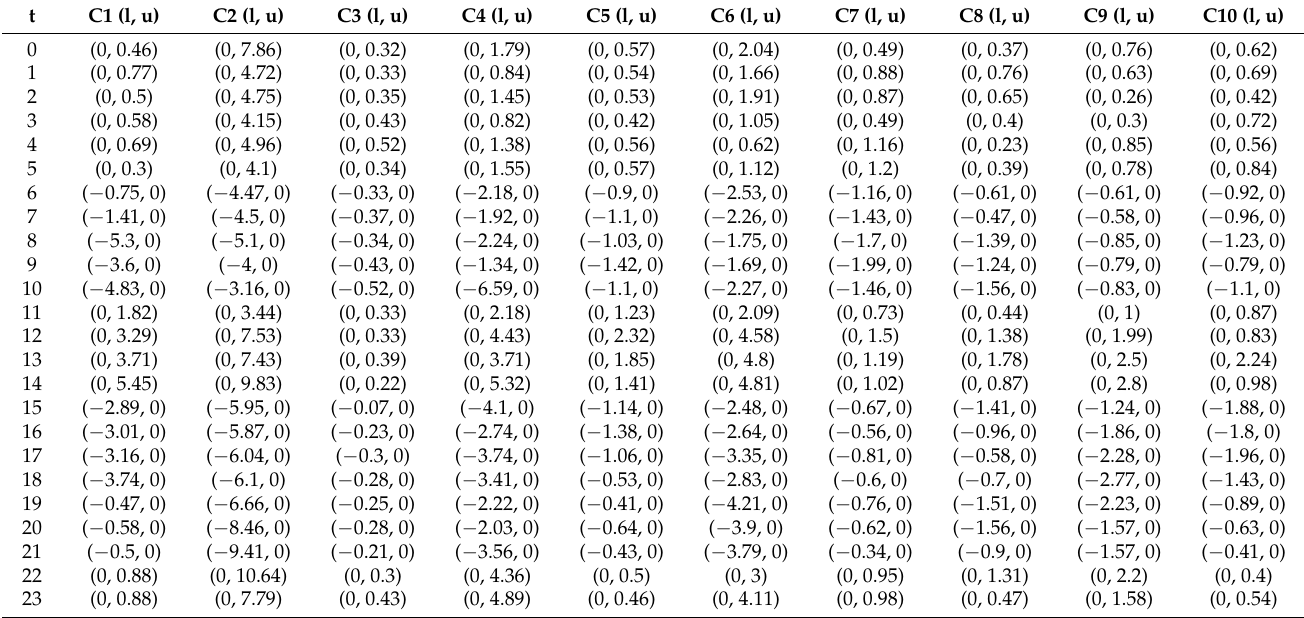
Table A2. Partial one day-ahead portfolio scheduling (10 consumers) with lower (l) and upper (u) bounds of flexibility contribution in